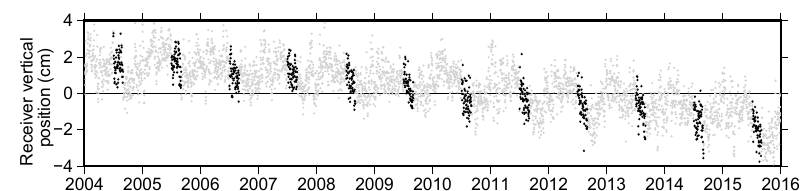
Figure 3. Time series of daily vertical positions of GPS receiver SG27, reflecting the solid earth movement (data source: http://geodesy.unr. edu/NGLStationPages/stations/SG27.sta). The mean has been removed. The black dots are from 1 July to 31 August. The rest are shown as gray dots. To simplify the figure, uncertainties of the receiver positions are not shown.